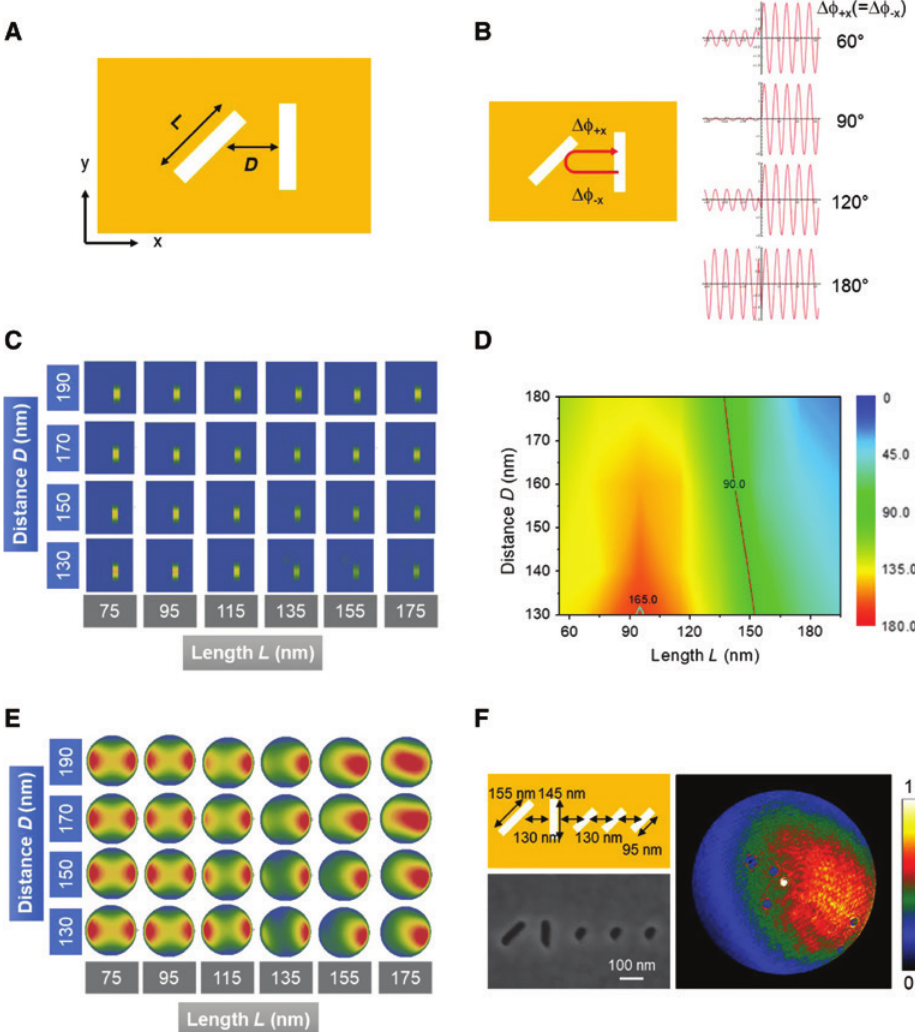
Figure 10: Optical multi-slot Yagi-Uda antennas. (A) Schematics of the slot-slot geometry. L and D correspond to the length of the rotated slot and the distance from the unrotated slot, respectively. (B) Simple model calculation of various phase differences. (C) E -field intensities calculated by 3D-FDTD while changing L and D . x The intensities are normalized by the maximum intensity. (D) Contour map of phase difference calculated by 3D-FDTD while changing L and D . The scale bar shows the phase difference between two slots in degrees. The red line corresponds to 90 ° phase difference. (E) Far-field radiation patterns calculated by 3D-FDTD while changing L and D . The intensities are normalized by the maximum intensity. (F) Schematics (top left) and SEM image of fabricated five-slot directional antenna (bottom left) and measured far-field radiation pattern of the fabricated sample (right). The white bar in SEM corresponds to 100 nm and the intensity of far-field radiation pattern is normalized by its maximum